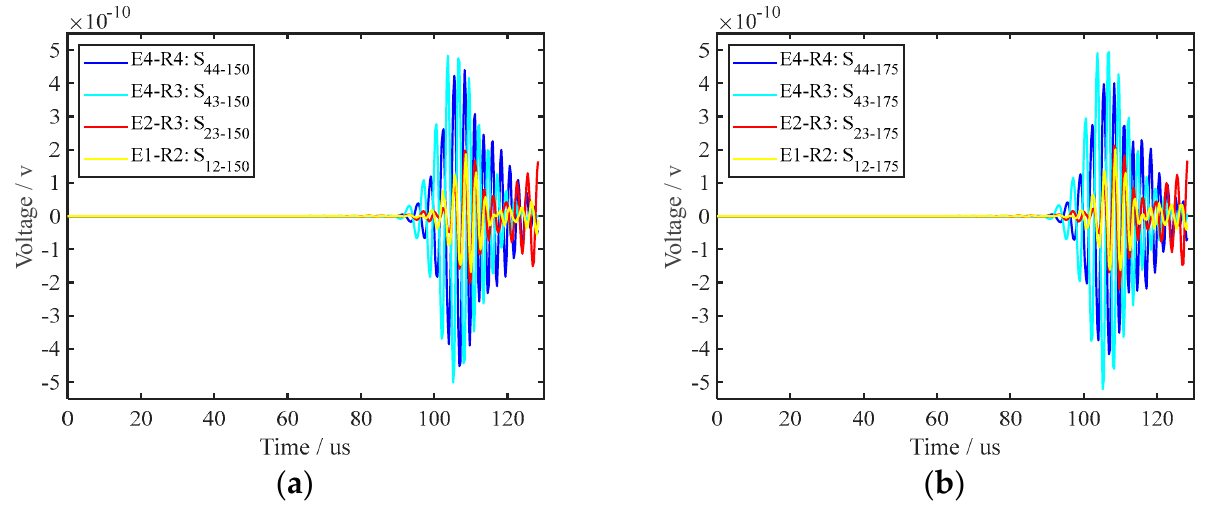
Figure 12. Signal amplitude variation in each path for cracks with large depths; ( a , b ) are the crack depths 15 mm and 17.5 mm, respectively.